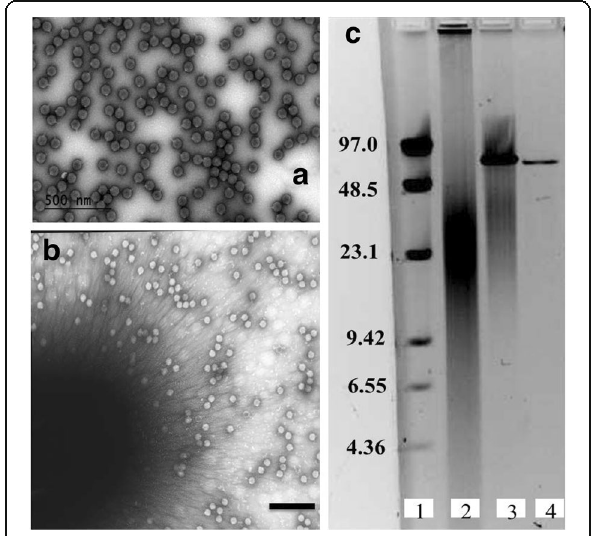
Fig. 1 Negative strain transmission electron micrographs of ( a ) RG-2014 virions (scale bar represents 100 nm), ( b ) RG-2014 infecting D. tsuruhatensis ARB1 (scale bar represents 1 μ m) and ( c ) Pulsed field electrophoresis gel strained with acridine orange; Lane 1, Molecular weight marker (numbers shown are in kbp); Lane 2, 2 μ g of DNA from phage RG-2014 virions; lane 3, same as lane 2 with 0.5 μ g of phage